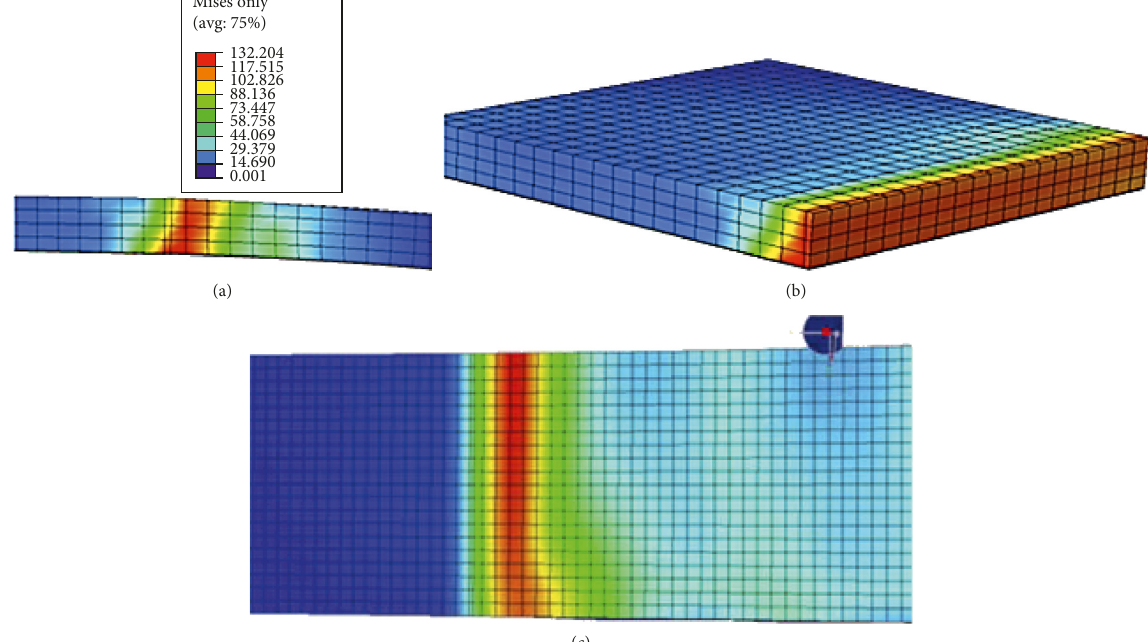
Figure 6: The distribution of equivalent stresses in the thermodeformation hearth (a, b) and in the contact zone of the tape with the surface of the part (c) during the electrocontact surfacing of the steel tape at K v � 1.015 and the duration of the current impulse t imp �